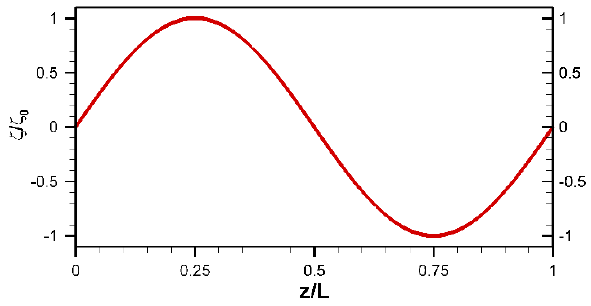
Figure 2. Schematic of the zeta potential distribution with a single period.